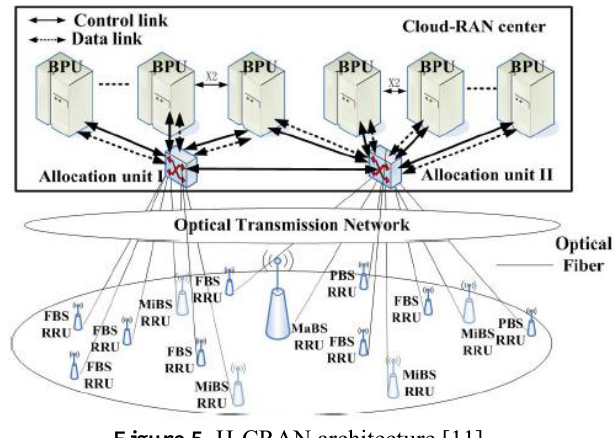
Figure 5. H-CRAN architecture